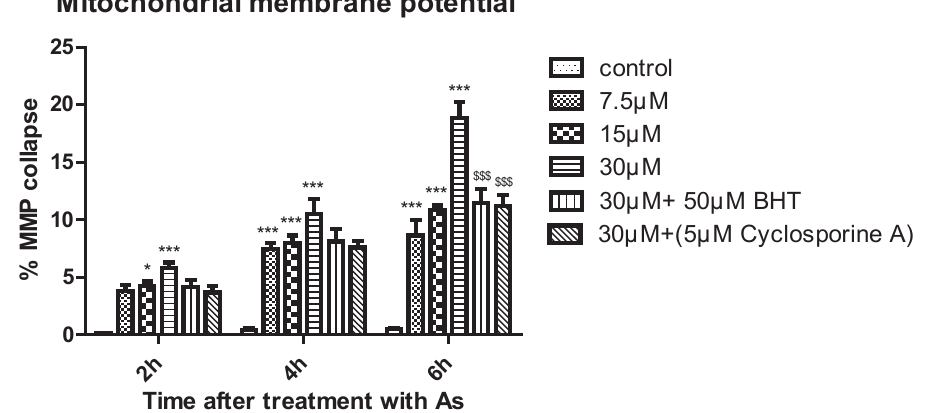
Figure 3: Collapse of mitochondrial membrane potential (MMP) in human lymphocytes following incubation with As for 2, 4 and 6 h. Significant (P < 0.05) collapse in mitochondrial membrane potential started 2h after treatment of human lymphocytes with As. Cyclosporine A and BHT prevented As-induced collapse in MMP. * (P < 0.05) and *** (P < 0.001): significant difference compared to the control group. $$$: significant difference with 30 µM As.